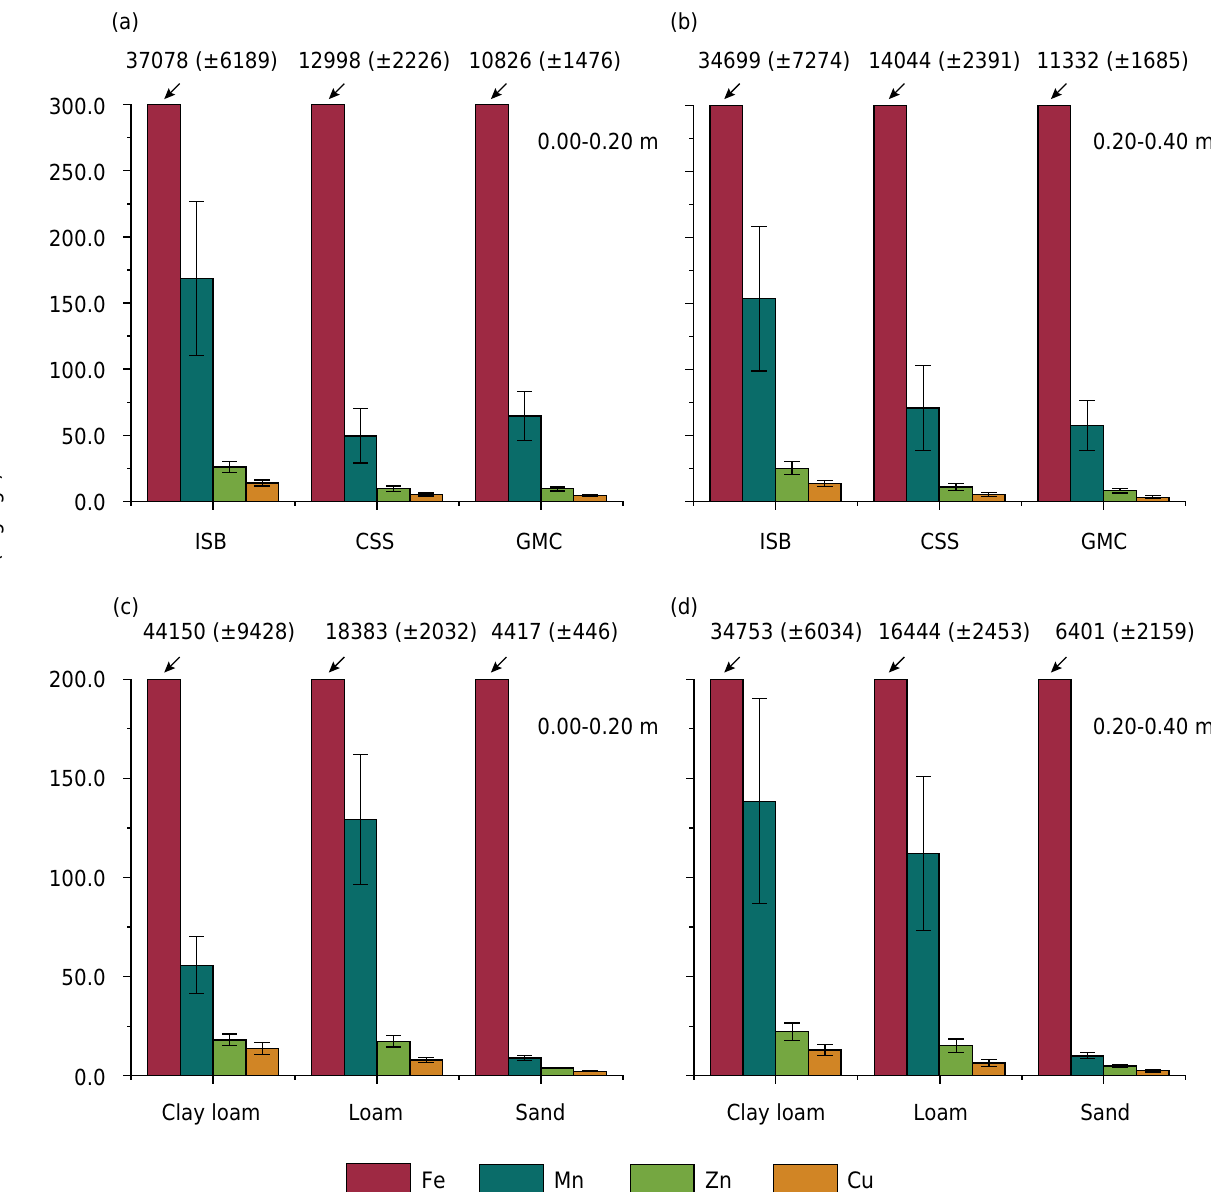
Figure 2. Micronutrient reserve contents and standard deviation in 0.00-0.20 and 0.20-0.40 m soil layers in different pedogeological contexts (a and b) and with different textural classes (c and d). ISB: igneous-sedimentary basin; CSS: clay-sandy sediments; GMC: gneissic-migmatite